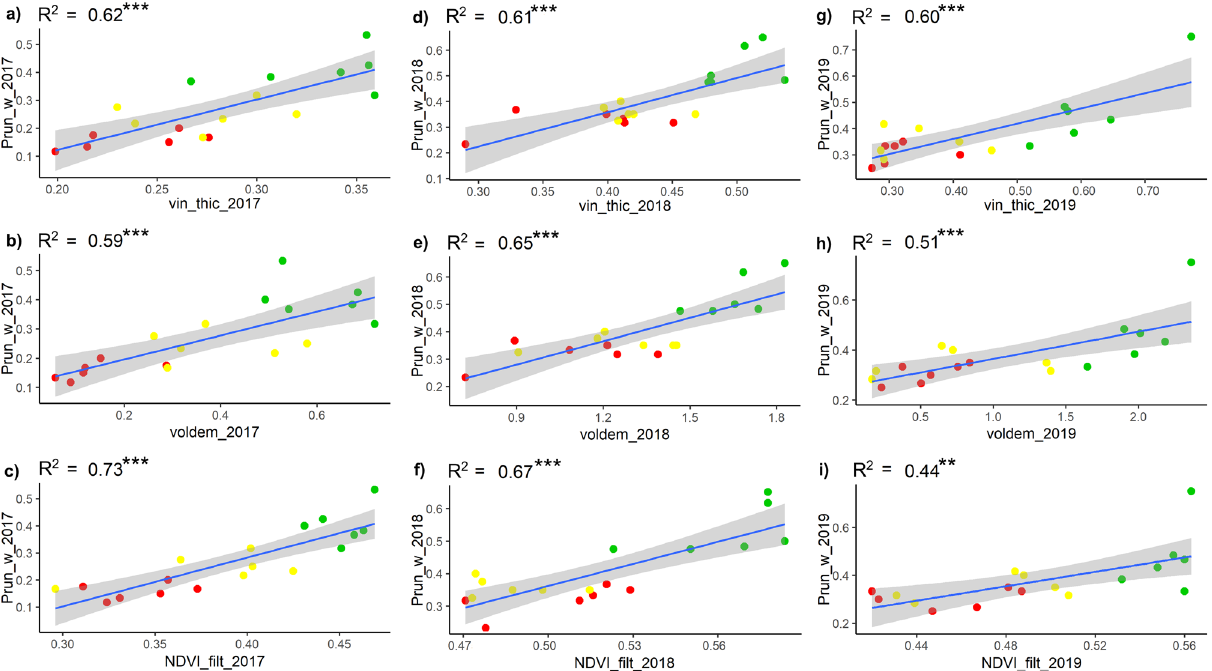
Figure 5. Linear regression results between ground measurements of pruning weight (kg) and UAV remote sensed data, represented by NDVI filtered, canopy thickness (m) and volume (m 3 ) in the HV (green dots), MV (yellow dots) and LV (red dots) zones. Significance: *** p < 0.001; ** p < 0.01; * p <